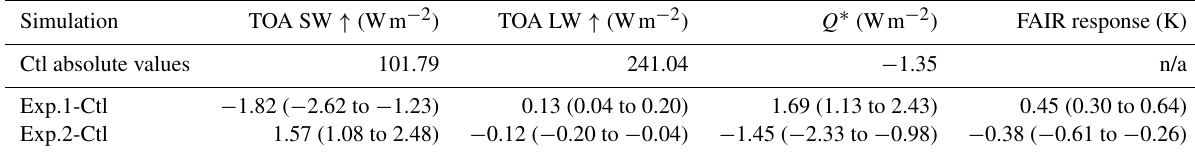
Table 3. Summary of the global mean (2000–2009) radiation fields: absolute Ctl values for the TOA shortwave (SW) and longwave (LW) outgoing and Q ∗ and the differences in these quantities resulting from Exp.1 and Exp.2 (from the Ctl) as well as the FAIR temperature response. The ranges shown for Exp.1 Ctl and Exp.2 Ctl indicate the 10th and 90th percentile confidence intervals. n/a – not applicable